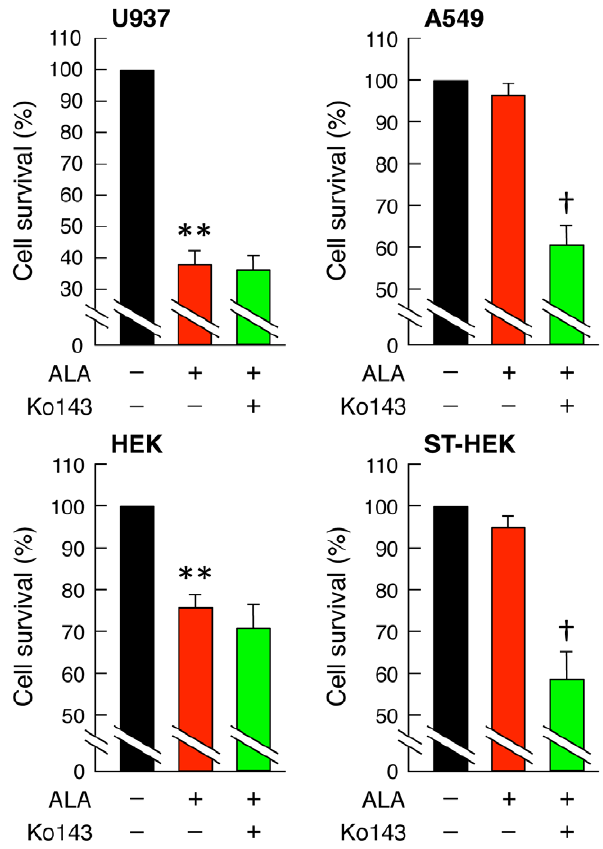
Figure 11. Effect of Ko143 on the cytotoxic damage of ALA- treated cancer cells by photodynamic treatment. Cells were exposed to light (29 mW/cm 2 ) for 10 min using a Na-Li lamp after 3 h treatment with 1 mM ALA in the presence or absence of 1 m M Ko143. Twenty-four h after irradiation, the MTT assay was performed. Results represent the mean 6 SD of three independent experiments. ** P , 0.01 vs. control. { P , 0.01 vs. ALA-treated.